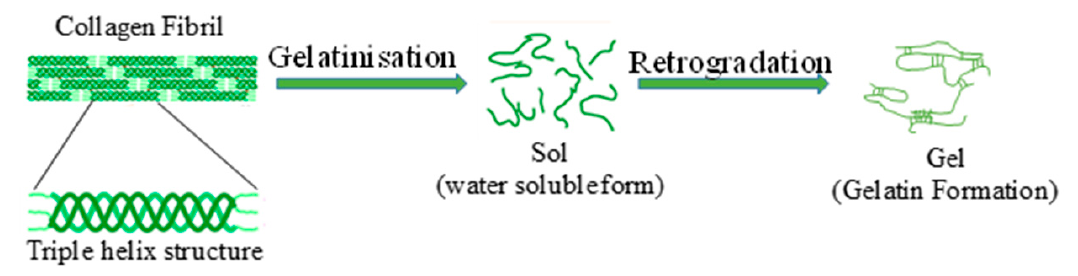
Figure 6. Gelatin made from collagen gelatinization (redrawn from von Endt and Baker 1991 [45]).